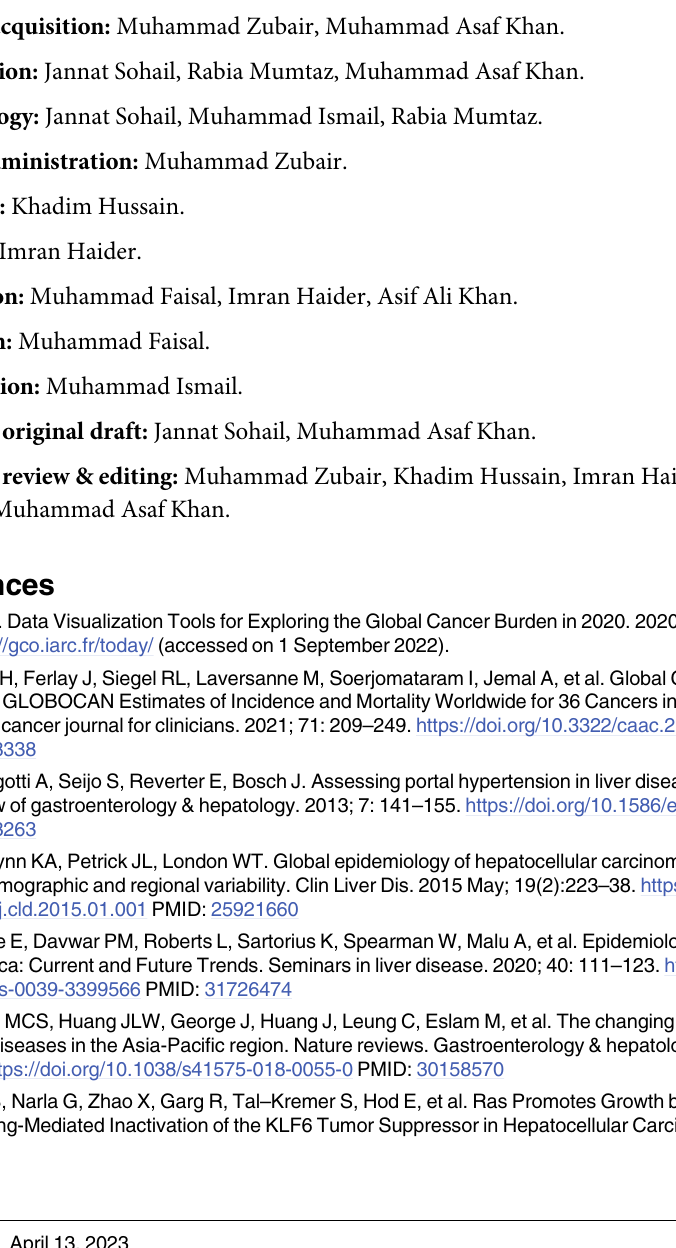
S22 Table. Experimental and predicted values for anti–diabetic activity of A . absenthia (Leaves, stem &